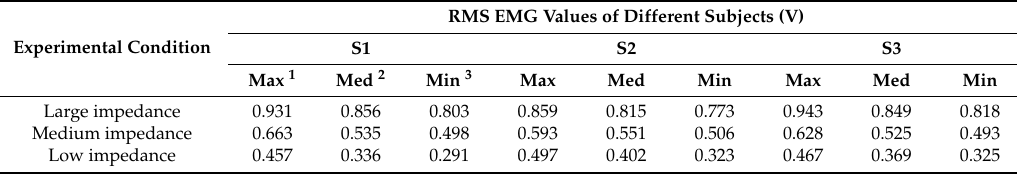
Figure 12. The comparison results of the RMS EMG values of different subjects and impedance parameters in five trials. Table 5. The statistical results of the RMS sEMG values of bicipital and triceps muscles of different volunteers under different impedance parameters.